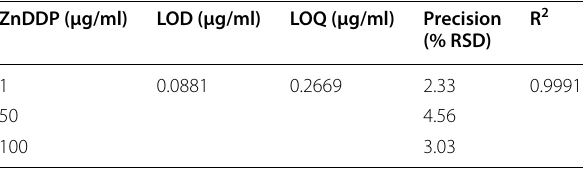
Table 1 Detection limits and calibration limits of ZnDDP, precision, and linearity